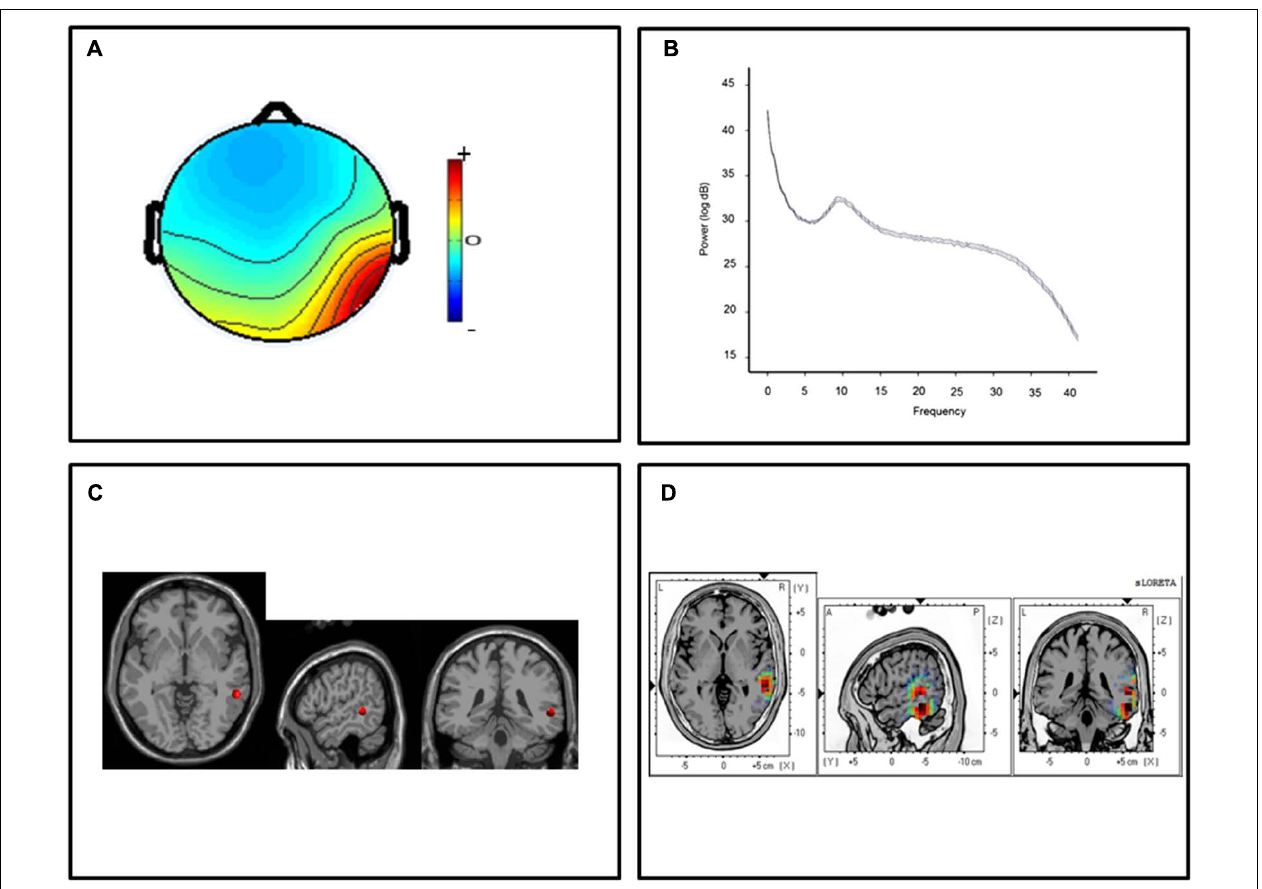
FIGURE 2 | Cluster results for the right-hemisphere α component. (A) Mean scalp potential distribution (W − 1 ) scaled to RMS microvolts and individual scalp distributions for each participant; (B) mean spectra of spectra of the component across cluster ICs. (C) Average equivalent